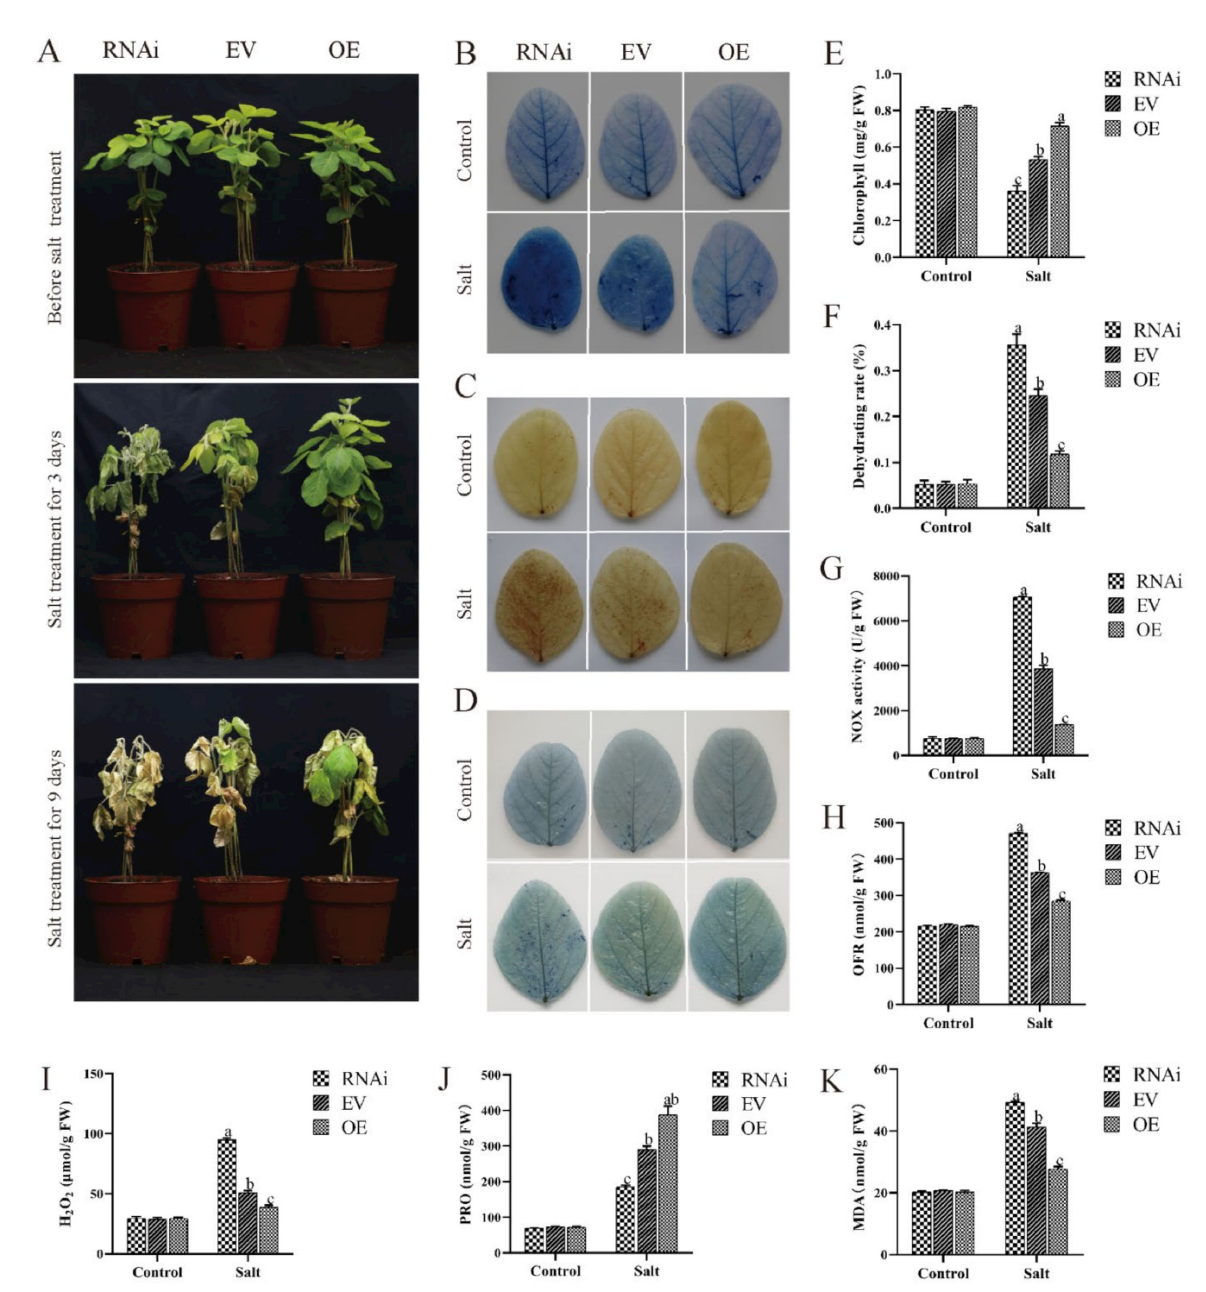
Figure 7. Under salt treatment, the phenotype of hairy root soybean, the states of difference hairy root plant leaves and the results of physiological index. ( A ) Images of salt-resistant phenotypes of the hairy root soybean plants of OE, EV and RNAi from the 250 mM NaCl stress or non-stress treatments are shown. ( B ) Trypan blue staining of dead cells (lives cells do not stain) in the hairy root soybean plants leaves after a week of salt treatment. DAB ( C ) and NBT ( D ) staining of leaves of the hairy root soybean plants of OE, EV and RNAi after salt or no-salt treatment for four days. Chlorophyll content ( E ), water-loss rate ( F ), NOX content ( G ), O 2 − content ( H ), H 2 O 2 content ( I ), proline content ( J ), and MDA content ( K ) were detected in leaves of the hairy root soybean plants of OE, EV and RNAi after a week-long salt or no-salt treatment. Three biological replicates were performed, and the values are means ± SD. Values marked with similar letters indicate not statistically significant differences (Student’s t- test: p ≤